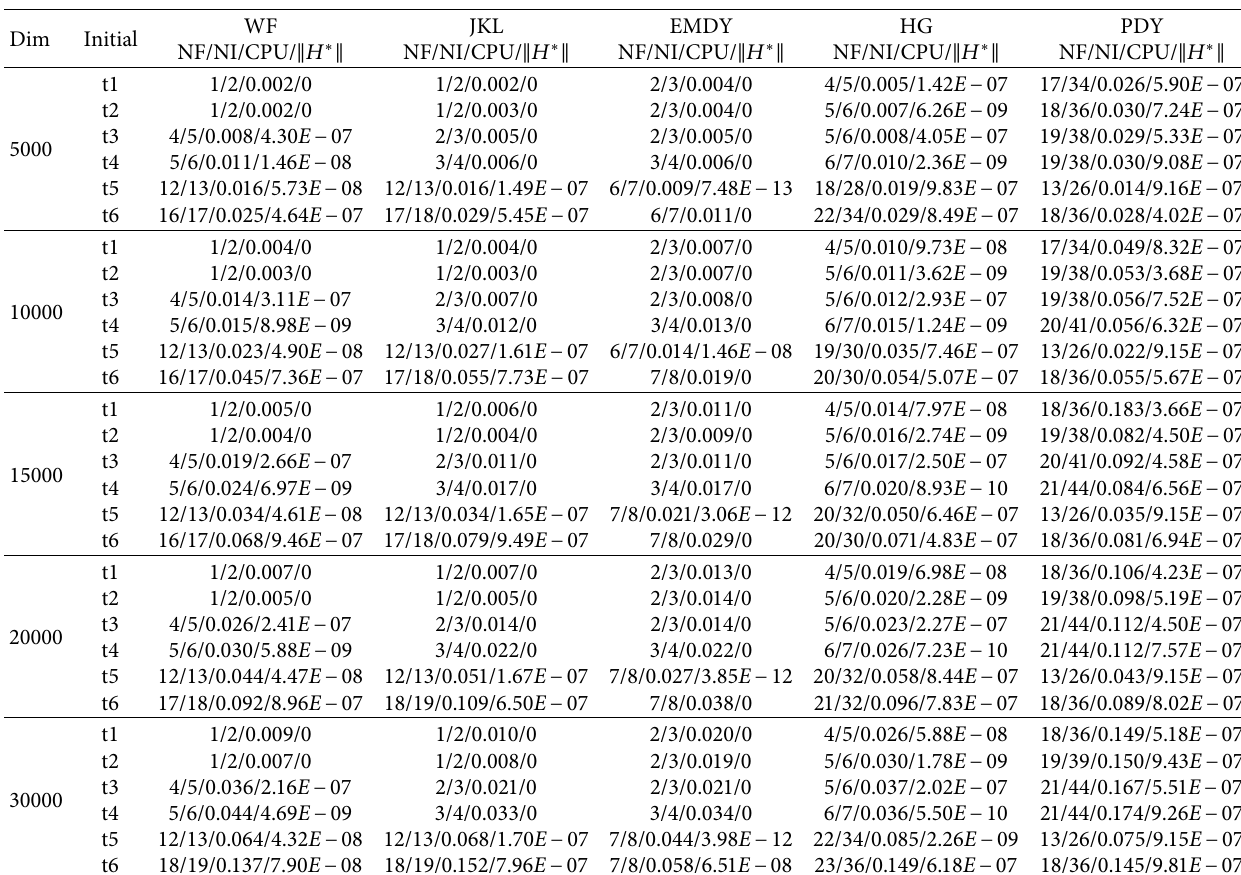
Table 3: Numerical results on problem